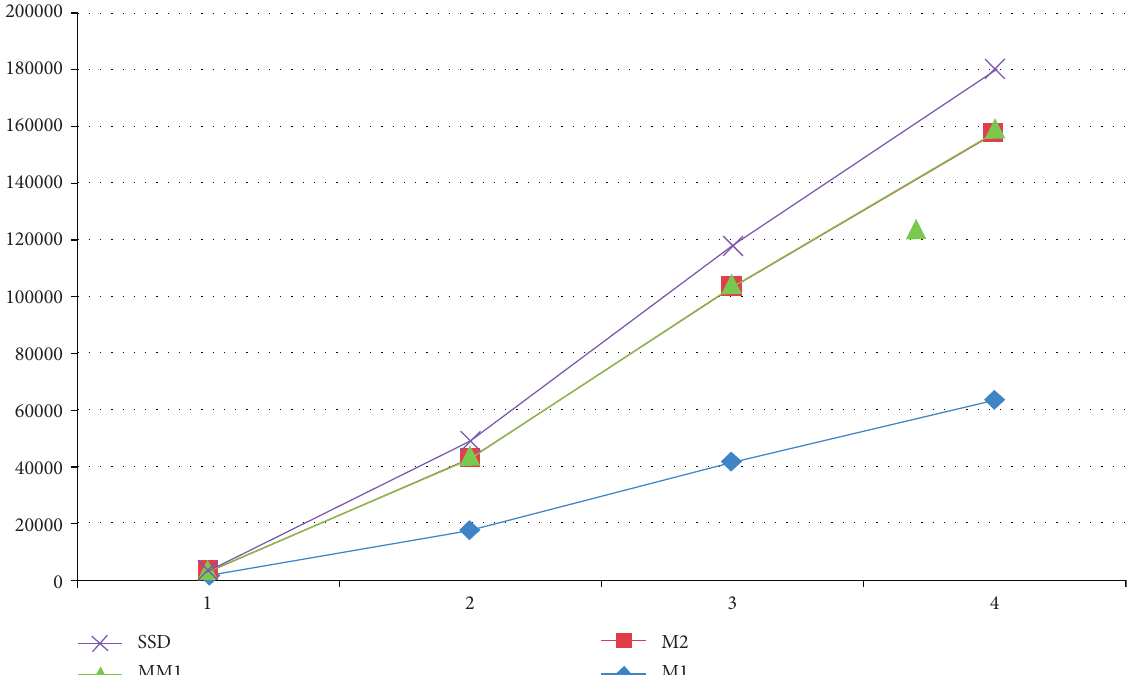
( Γ ) , M ( Γ ) , MM 1 2 2 2